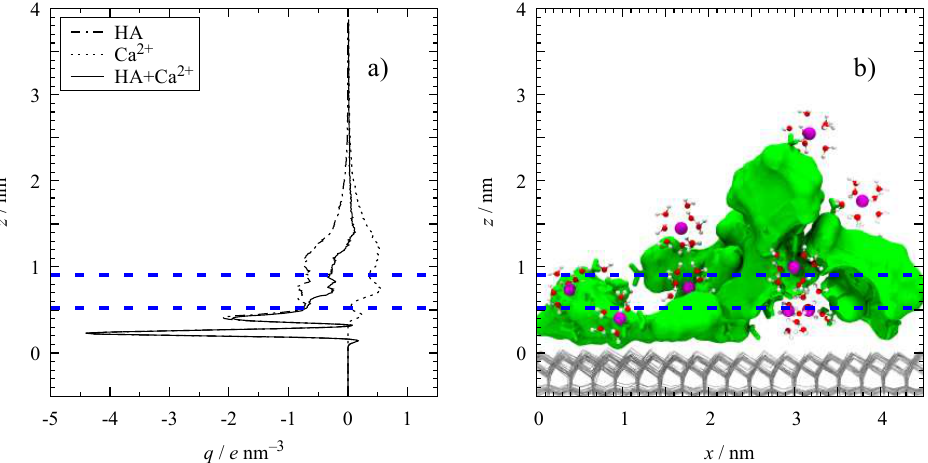
Figure 3. Charge density profiles, q , of humic acid (HA), calcium (Ca 2+ ), and their sum (HA+Ca 2+ ) as a function of the distance, z , from the aluminol surface ( a ). Side view ( xz –plane) of the simulation box exhibiting HAs (green isosurfaces) forming aggregates through cation bridges ( b ). Basal oxygen atoms of the surface are taken as a reference position ( z = 0). The first, second, and third Ca 2+ peaks are divided by dashed blue lines. Ca 2+ cations are represented as magenta balls and the surrounding water molecules as balls and sticks. For clarity, all other water molecules are not shown.